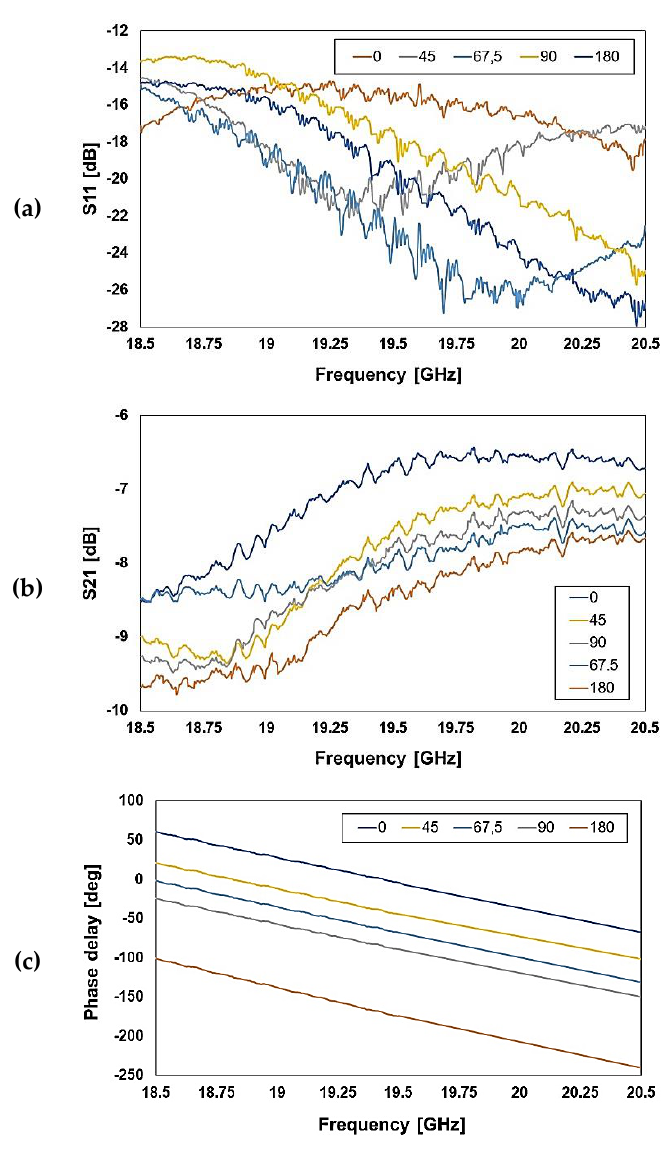
Figure 10. Measured characteristics of the reflection ( a ), transmission ( b ), and phase delay ( c ) for the 19.5 GHz center frequency RF-MEMS phase shifter (K band).